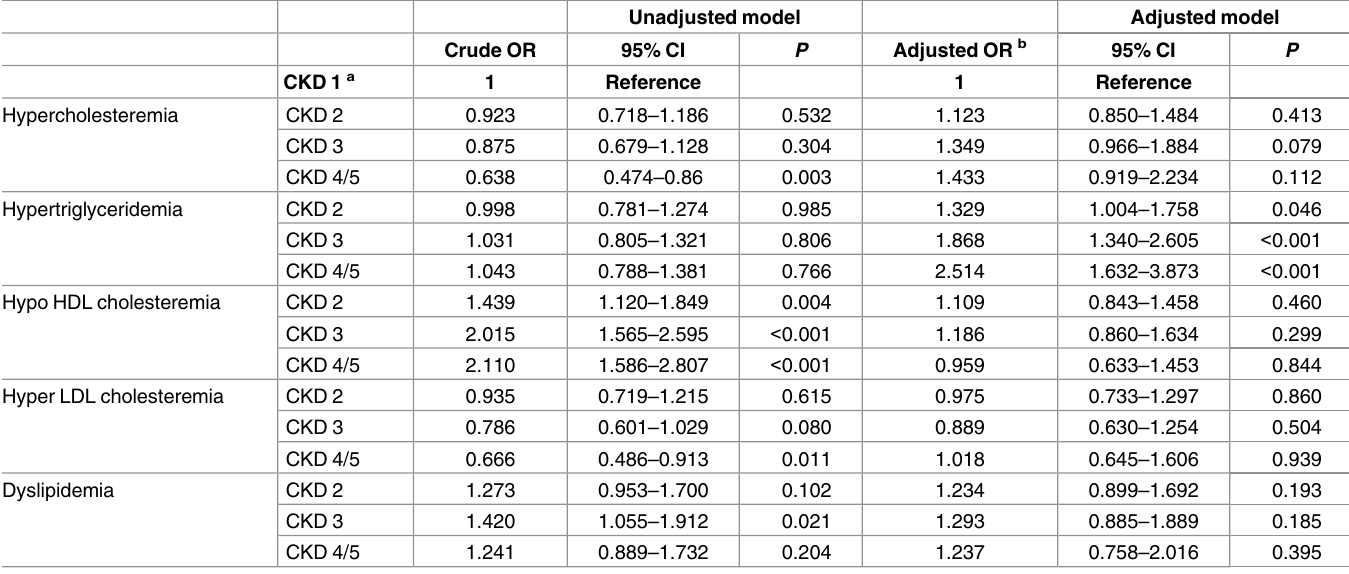
Table 4. Logistic regression analysis of the association between CKD stages and different types of dyslipidemia. CI indicates confidence